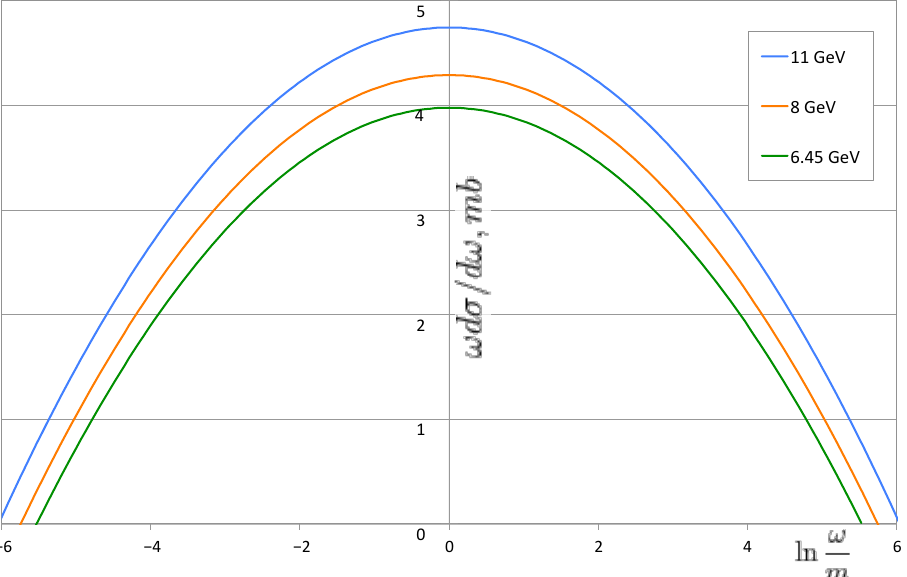
√ s nn = 11 GeV ( blue , upper), 8 GeV ( red , middle),